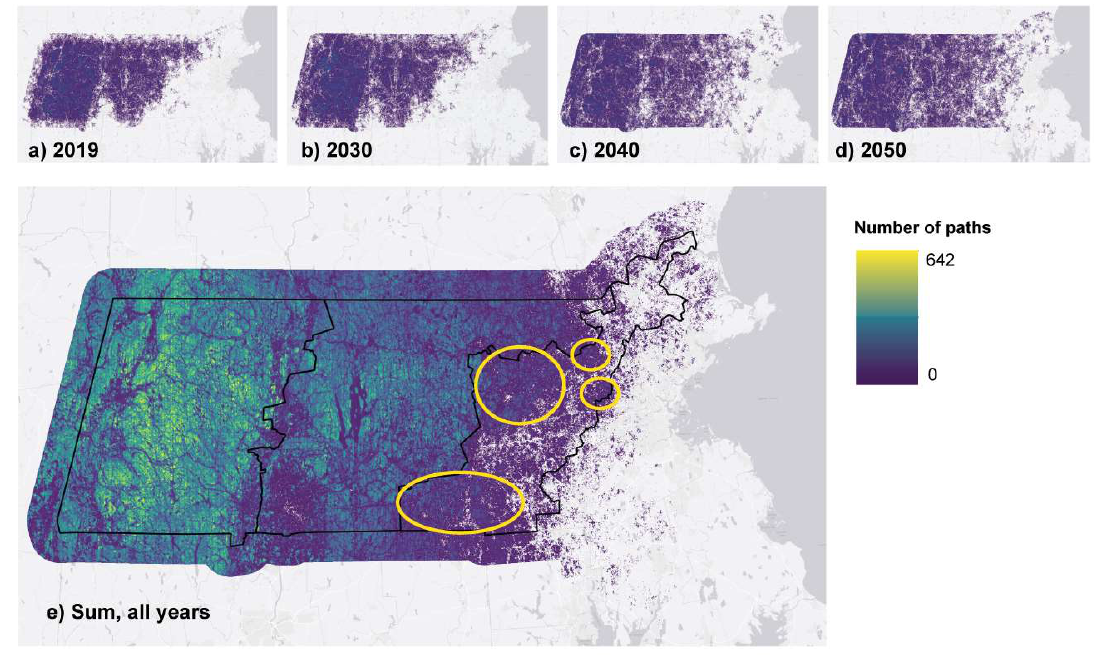
Figure 4. Per-pixel sum of simulated black bear paths for ( a ) 2019, ( b ) 2030, ( c ) 2040, ( d ) 2050, and ( e ) all years (2019 to 2050). From west to east, the black polygons represent black bear range to the west of the Connecticut River, to the east of the river, and the expanding range. Yellow circles indicate areas with substantial future black bear use in their expanding range. The locations of the two larger and smaller circles are described further in the Results section.